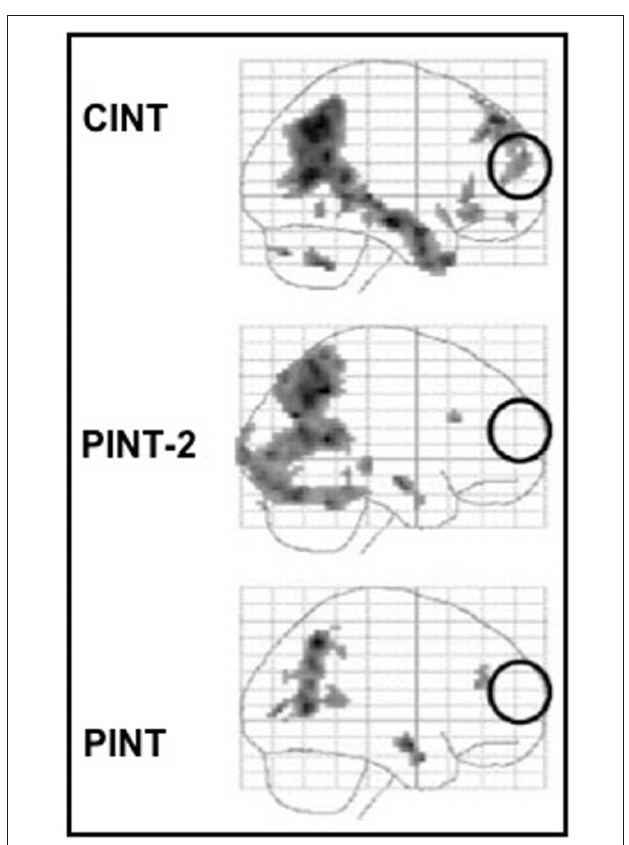
FIguRe 5 | Main effects for the three experimental conditions (PInt, PInt-2, CInt) vs control condition (Ph-C). Second level, one sample t -test, p < 0.001 uncorrected. Ph-C, Physical causality; PInt, Private intention; PInt-2, Private intentions by two agents; CInt, Communicative